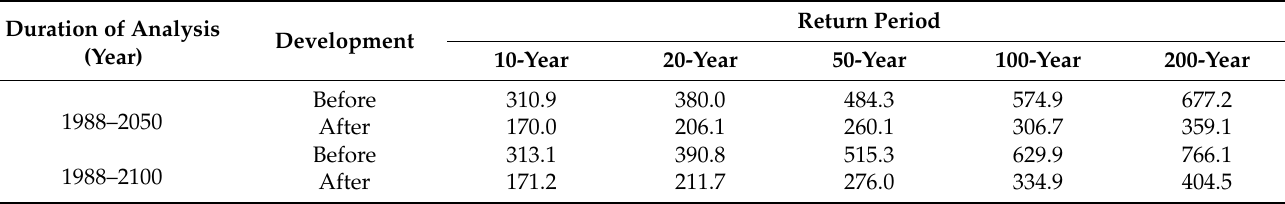
Table 13. Runoff by return period using RCP 8.5 scenario (unit: m 3